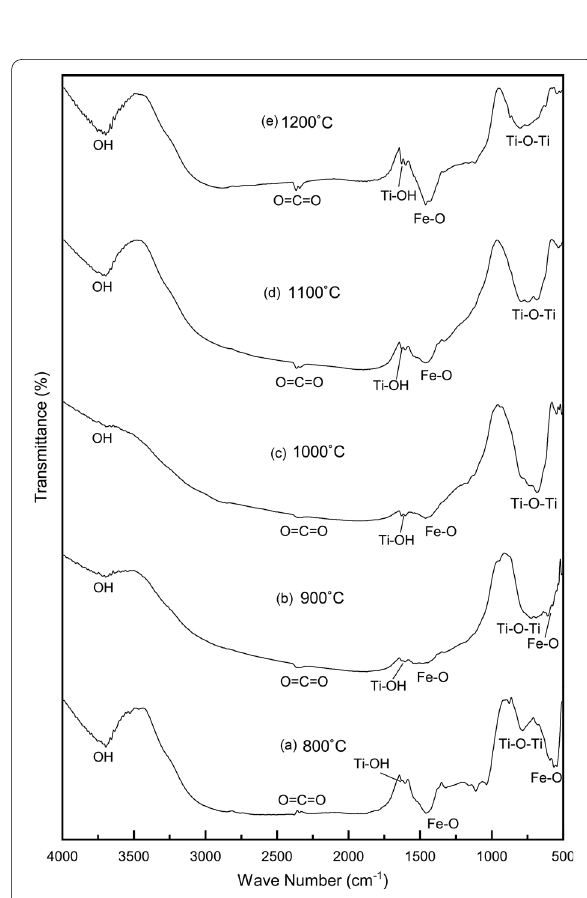
Fig. 6 FTIR spectra of 4 h milled ilmenite samples ( a ) annealed at 800 °C, ( b ) annealed at 900 °C, ( c ) annealed at 1000 °C, ( d ) annealed at 1100 °C, and ( e ) annealed at 1200